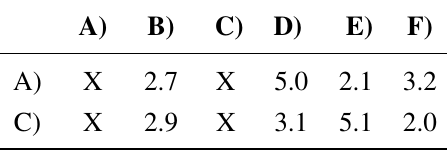
Table 2. Fictitious example: common exposures of institutions A and C .